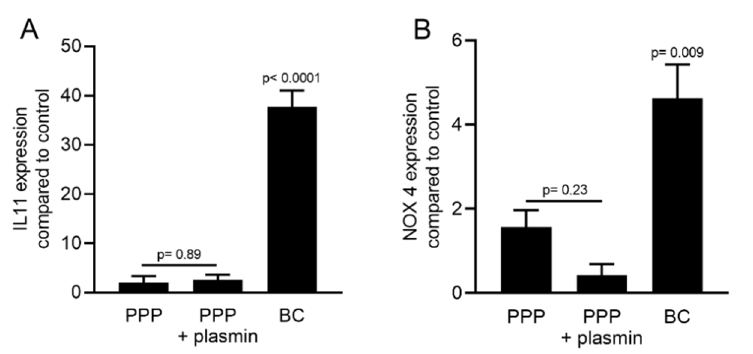
Figure 7. The plasmin-digested PPP fraction at 1500 g did not increase TGF- β target genes expression. Gingival fibroblasts were exposed to 30% of the BC and PPP fraction of PRF lysates prepared at 1500 g and the plasmin-digested PPP fraction. Gene expression analysis indicated that plasmin digestion is not sufficient for PPP to make changes in the expression of IL11 ( A ) and NOX4 ( B ). Data represent the mean and standard deviation of three independent experiments. Statistical analysis was performed using ANOVA ( n = 3).